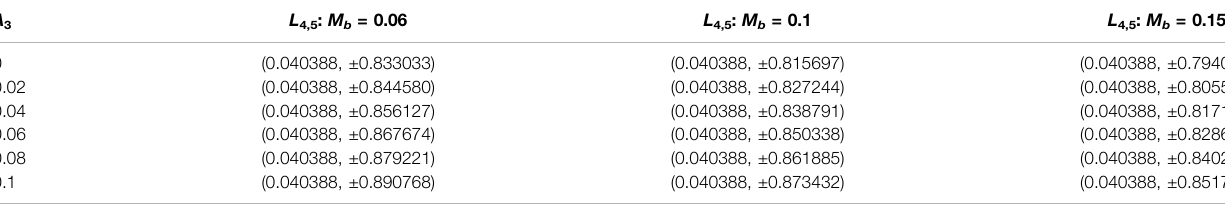
TABLE 6 | Positions ( x 0 , 0) of the collinear points of the binary HD155876 system for fi xed values q 1 = 0.979950, q 2 = 0.983912, T = 0.01, σ 1 = 4 × 10 − 5 , σ 2 = 3 × 10 − 5 , ′ (cid:1) 2 × 10 − 5 , σ ′ (cid:1) 10 − 5 , and for two fi xed values of M σ 1 2